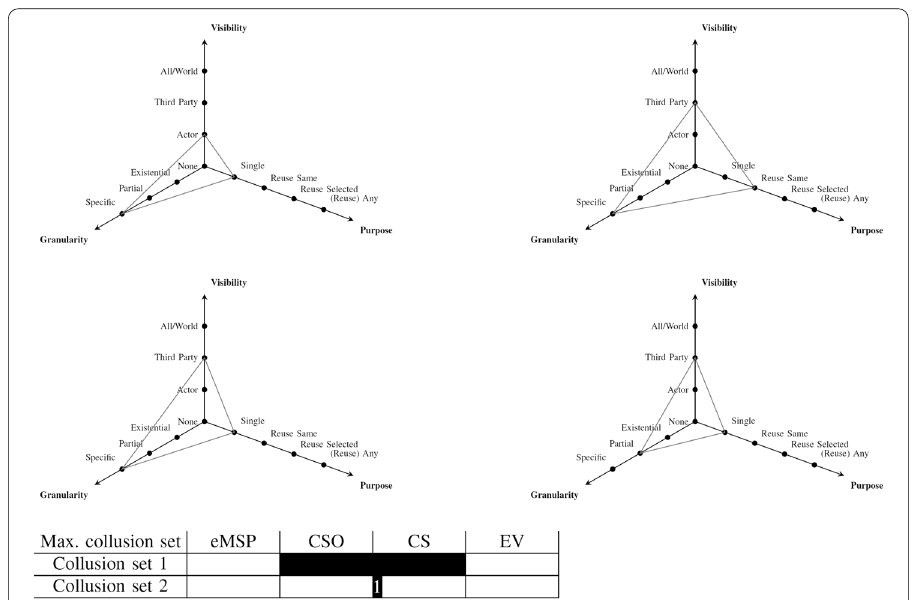
Fig. 7 Privacy dimensions and visualization for collusion sets for (Li et al. 2014) for data items (i) personal data/ID (top left), (ii) time (top right), (iii) location, charging parameters, amount of energy (bottom left), and (iv) aggregated energy (bottom right). Collusion set 1 refers to the mapping between the ID of the EV and its identity. Collusion set 2 refers to the potential learning of driving directions and